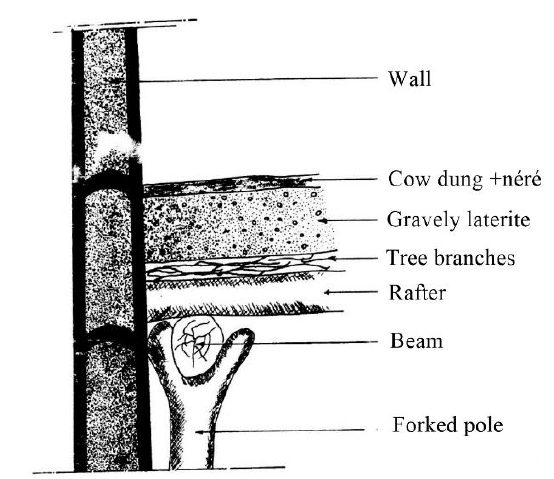
Figure 5. Detail of the flat roofing system (Yavo,